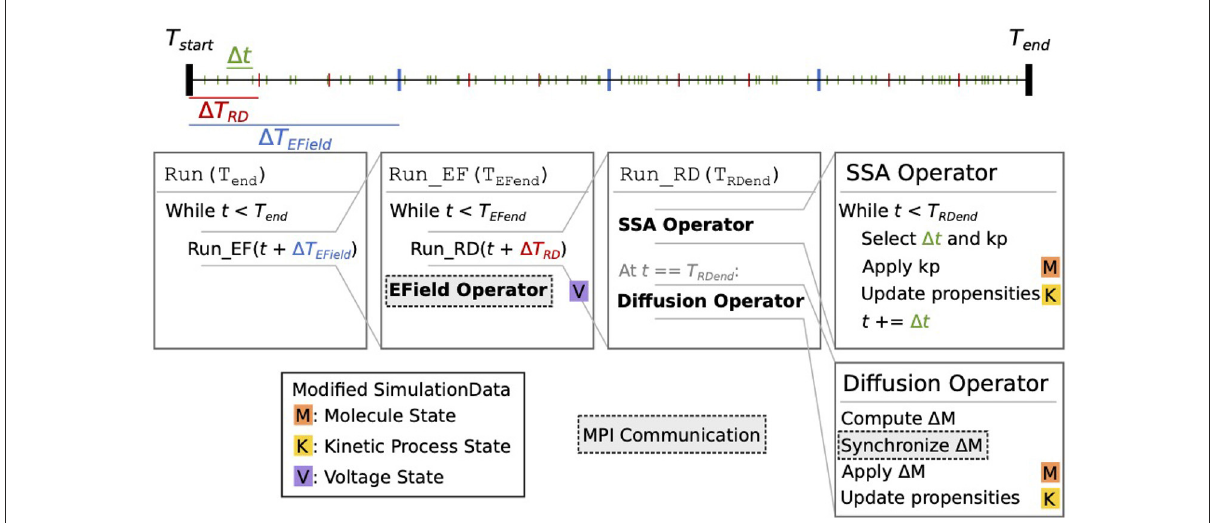
FIGURE2 Schematic representation of the STEPS 4 simulation core loop. In this example, when running the simulation from T start to T end , the simulation time is first split into 1 T EField time windows (blue ticks). Each 1 T EField time window is further subdivided into 1 T RD time windows (red ticks). Kinetic process events are represented as green ticks, their number in each time window depends on the propensities of the reactions. Current state time is denoted t . The leftmost Run(T end ) box is the entry point into the core loop, it splits the time in 1 T EField time windows. The second box ( Run_EF(T EFend ) ) runs a full EField time step until T EFend , the end-time that was passed from the first loop. It first subdivides the EField time window in 1 T RD time windows and calls Run_RD for each one. When state time t reaches T EFend , it runs the EField operator. The third box ( Run_RD(T RDend ) ) represents one RD time window, it is composed of the SSA operator and the diffusion operator. The SSA operator first selects and applies kinetic processes until the state time reaches T RDend ; it’s in this loop that the state time is updated. The diffusion operator is then applied: it computes the changes 1 M to the molecule state and applies them. Each of these steps can involve the modification of the simulation data. When it does, a letter with a colored background is present to its right. The letter M with an orange background signifies that this operation modifies the molecule state; the letter K with a yellow background signifies that it modifies the kinetic process state; and the letter V on a purple background signifies that it modifies the voltage state. Finally, steps with a darker background and a dashed outline involve MPI communication between